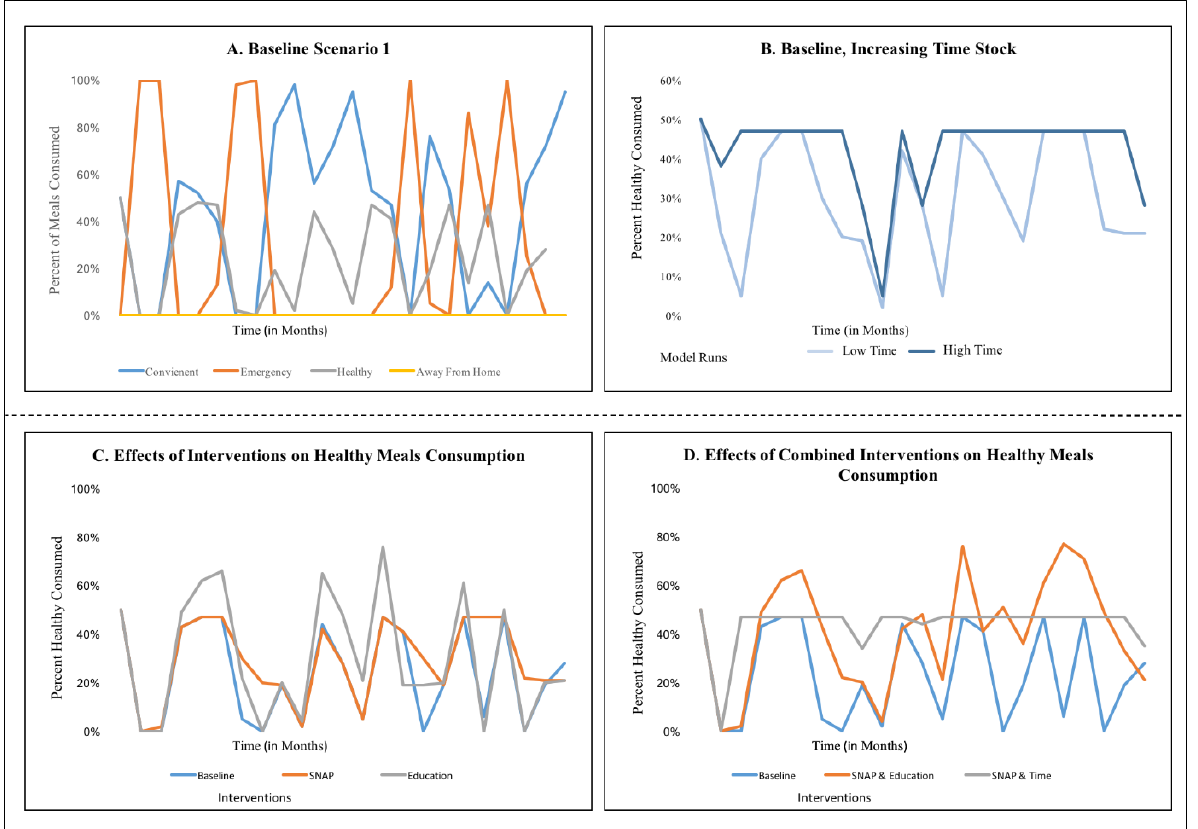
Figure 4. Scenario 1: Low Income, No Car, No Assistance, Variable Work